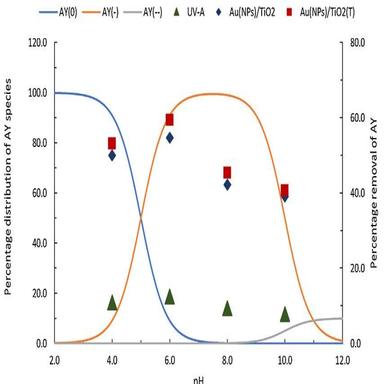
Percentage distribution of Alizarin Yellow species as a function of pH (Smooth Line) and percentage removal of Alizarin Yellow at various pH values (Scattered Points) for catalytic and photolytic treatments .